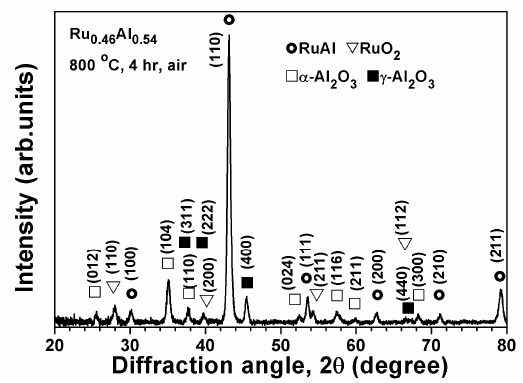
Figure 13. XRD pattern of the Ru 0.46 Al 0.54 /Ru/Inconel 617 sample after annealing in air at 800 °C for 4 h.